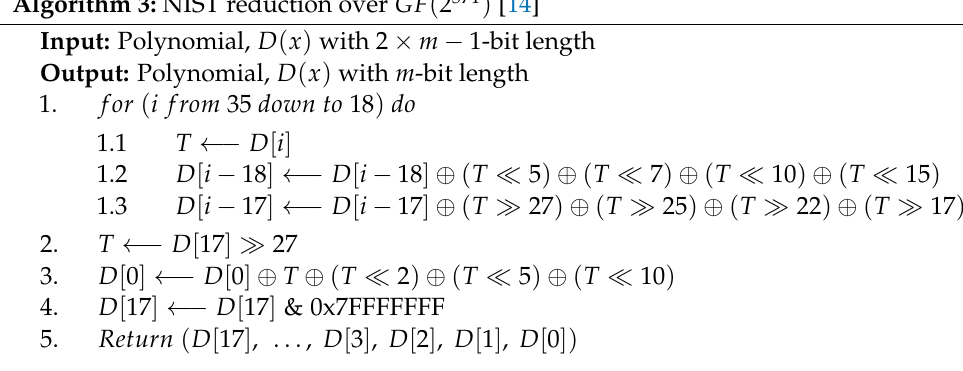
Algorithm 3: NIST reduction over GF ( 2 571 )